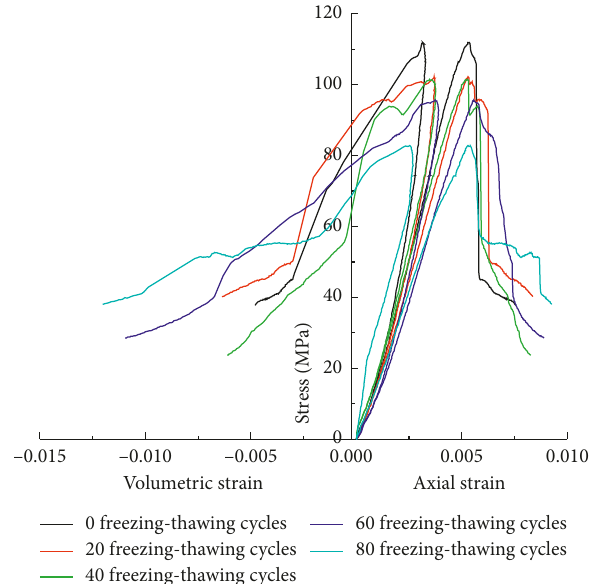
Figure 6: Stress-strain curves of sandstone after various freezing-thawing cycles. Table 1: Mechanical properties of sandstones under unloading tests after various freezing-thawing cycles. Number of